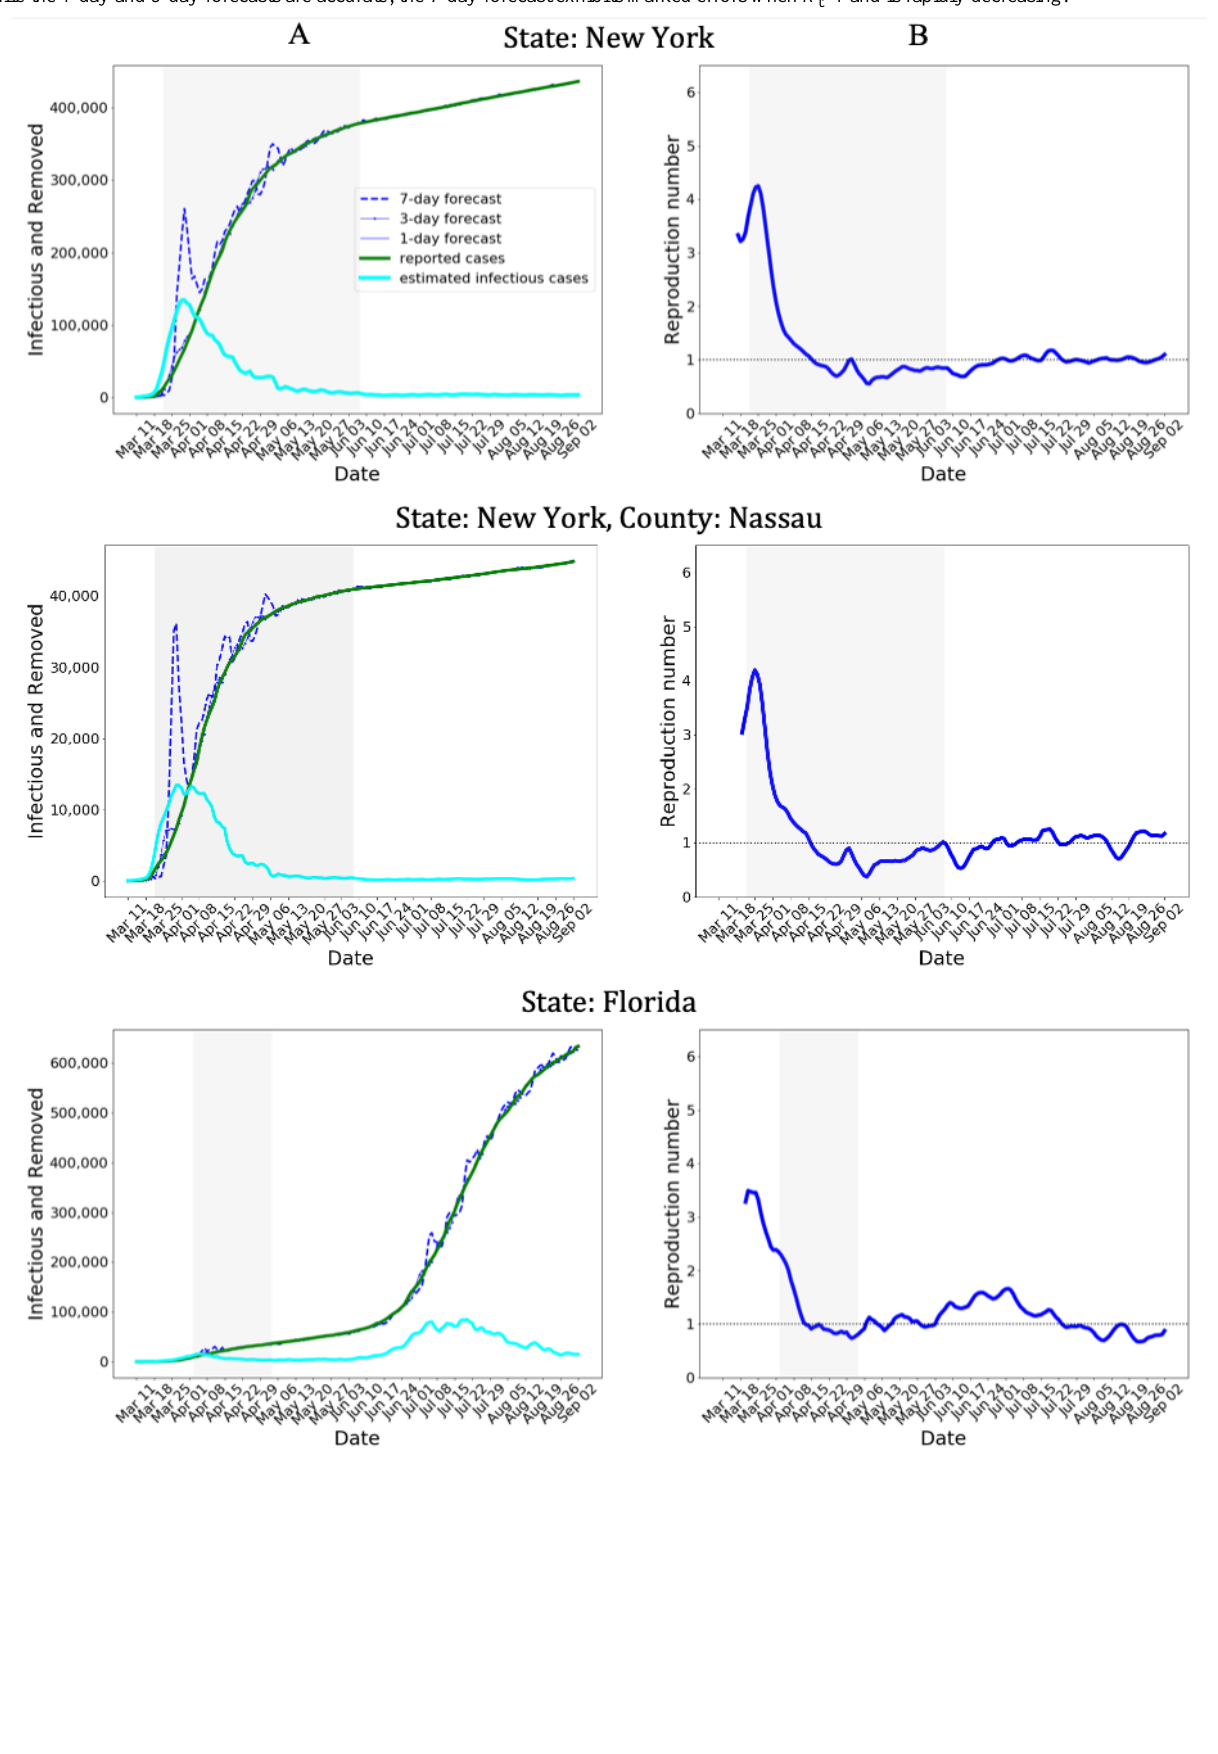
Figure 1. (A) Estimated Infectious and forecast Removed. (B) Estimated reproduction number R t . The shaded region indicates the dates of the lockdown. While the 1-day and 3-day forecasts are accurate, the 7-day forecast exhibits marked errors when R t >1 and is rapidly